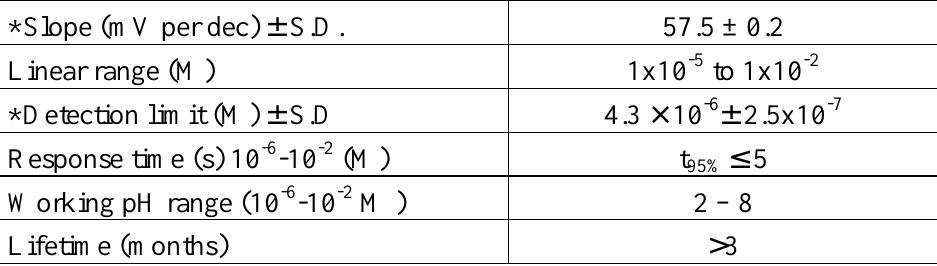
Table 2. Response characteristics of the tiapride-selective